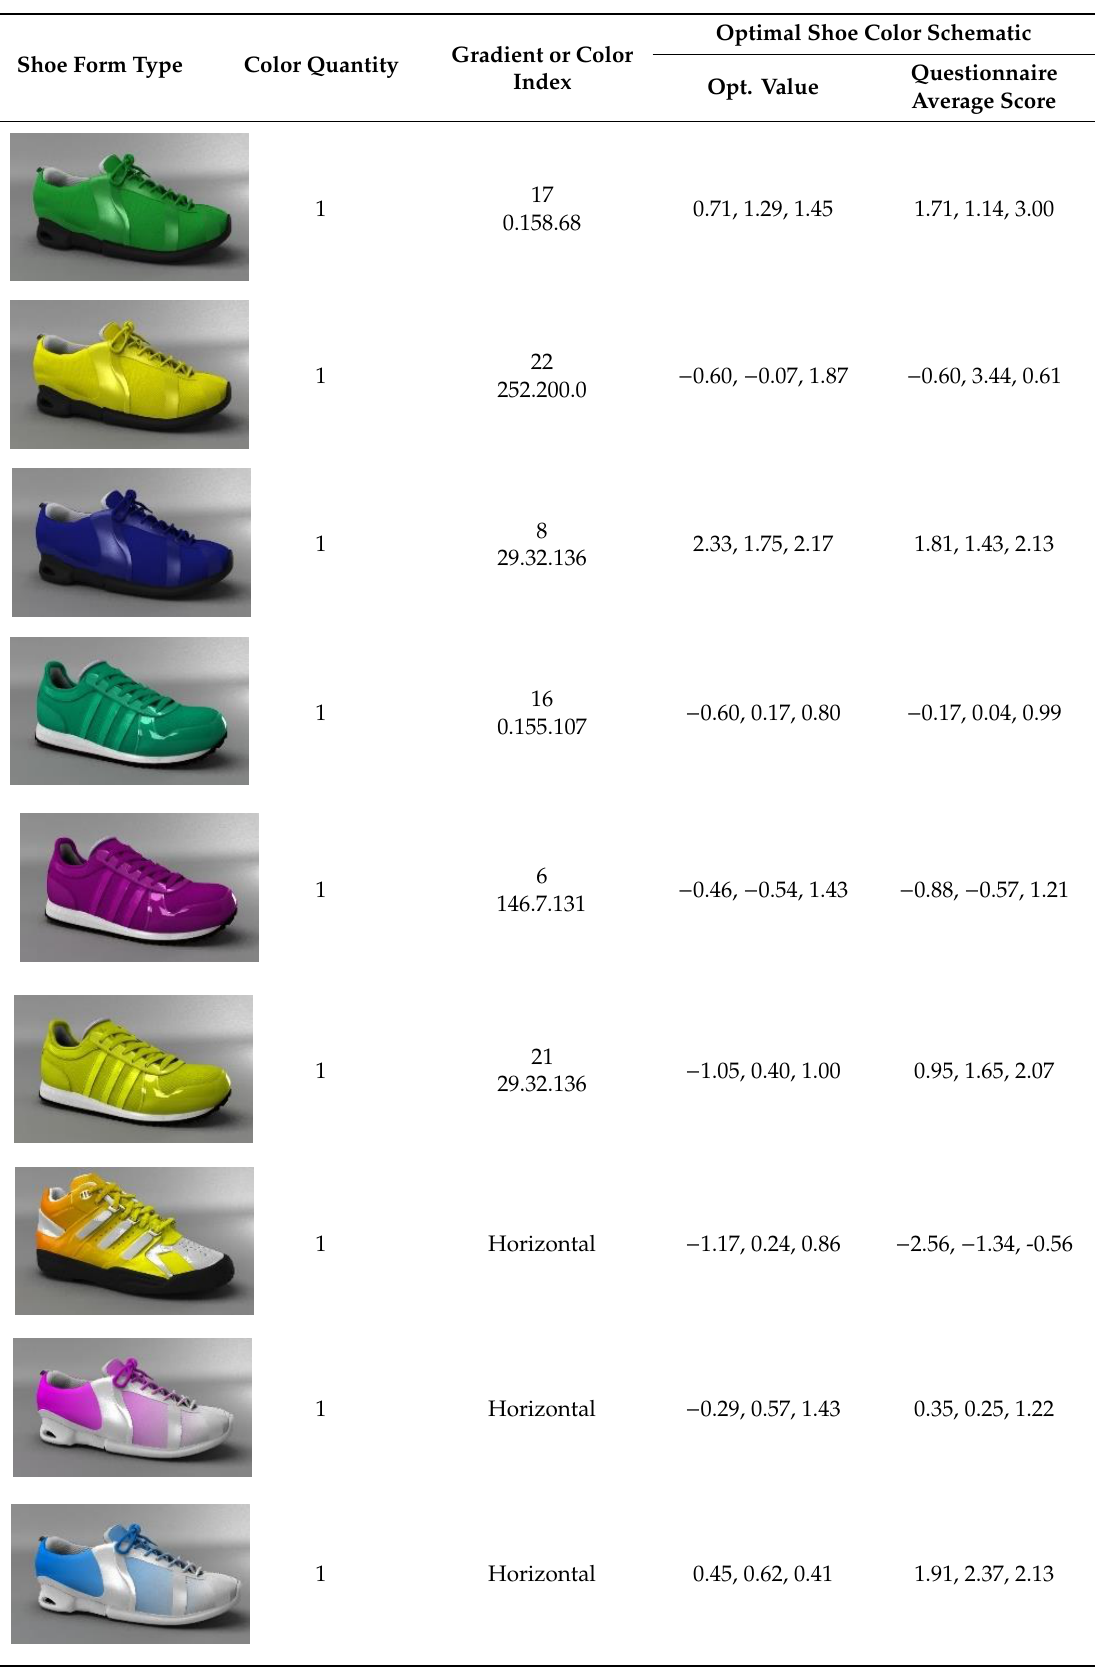
Table 9. Shoe designs for which relatively large prediction errors in the ANN were generated.